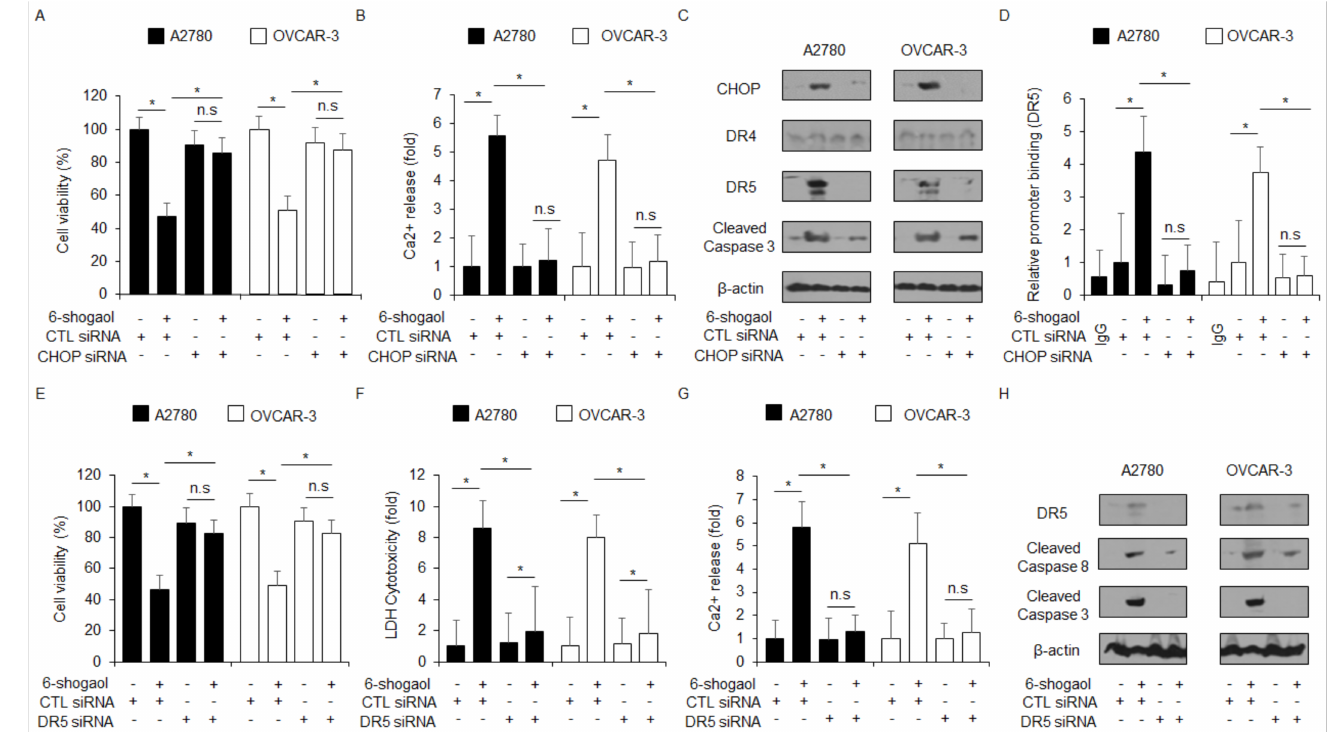
Figure 5. 6-shogaol induces the binding of CHOP on DR5 promoter in ovarian cancer cells. ( A – D ) After A2780 and OVCAR-3 cells were transfected with CHOP siRNA (30 nM, 24 h), WST-1, intracellular Ca 2+ assay, Western blotting analyses, and ChIP assay were performed with/without 6-shogaol (30 µ M, 24 h) treatment.; *, p < 0.05. Western blotting analyses were carried out to de- termine the expression of CHOP, DR4, DR5, and caspase-3 cleavage in 6-shogaol-treated CHOP knockdown cells. β -actin was used as a protein loading control. ( E – H ) After A2780 and OVCAR-3 cells were transfected with DR5 (30 nM, 24 h), WST-1, LDH cytotoxicity assay, intracellular Ca 2+ assay, and Western blotting analyses were performed with/without 6-shogaol (30 µ M, 24 h) treatment.; *, p < 0.05. n.s = not significant. Western blotting was carried out to identify the expression of DR5, caspase-3, and caspase-8 cleavage in 6-shogaol-treated DR5 knockdown cells. β -actin was used as a protein loading